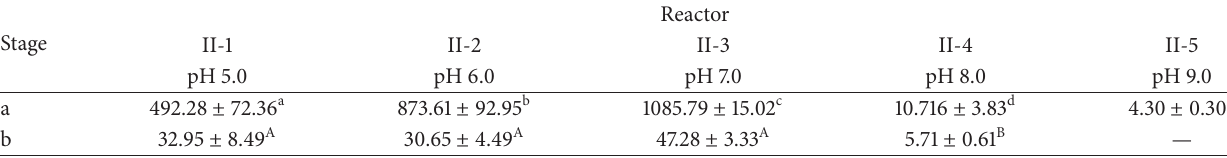
Table 2: Amount of target gene hsp in the inoculated reactors with different initial pH.